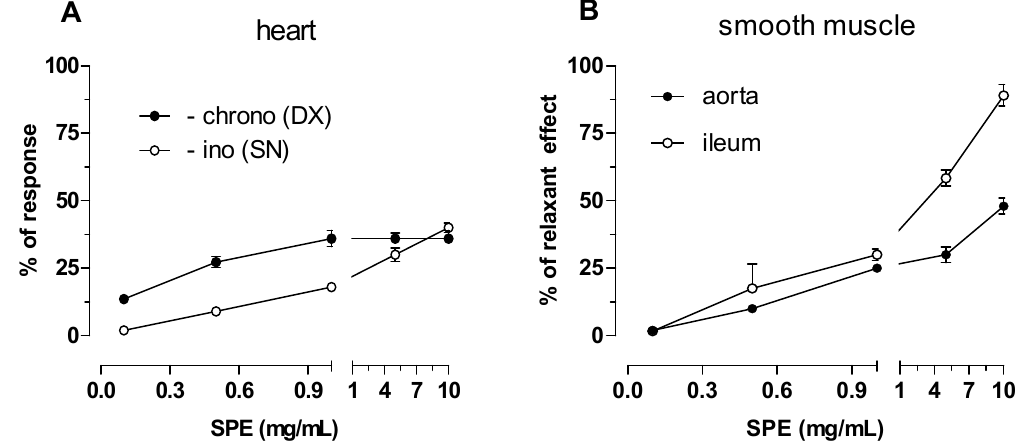
Figure 2. ( A ) Negative inotropic and chronotropic e ff ects on guinea pig left and right atrium respectively. Cumulative concentration–response curves for Sa ff ron Petal Extract (SPE) were obtained using negative e ff ects as percentage of the initial tension (left atria) and initial rate (right atria). ( B ) Spasmolytic e ff ect of SPE on 80 mM K + -induced contraction on guinea pig vascular (aorta) and non-vascular (ileum) smooth muscle. Cumulative concentration–response curves for SPE were obtained using relaxant e ff ects as percentage of the initial tension induced by 80 mM K + , taken as 100%. Each point is the mean ± SEM ( n = 5–6). Where error bars are not shown these are covered by the point itself.